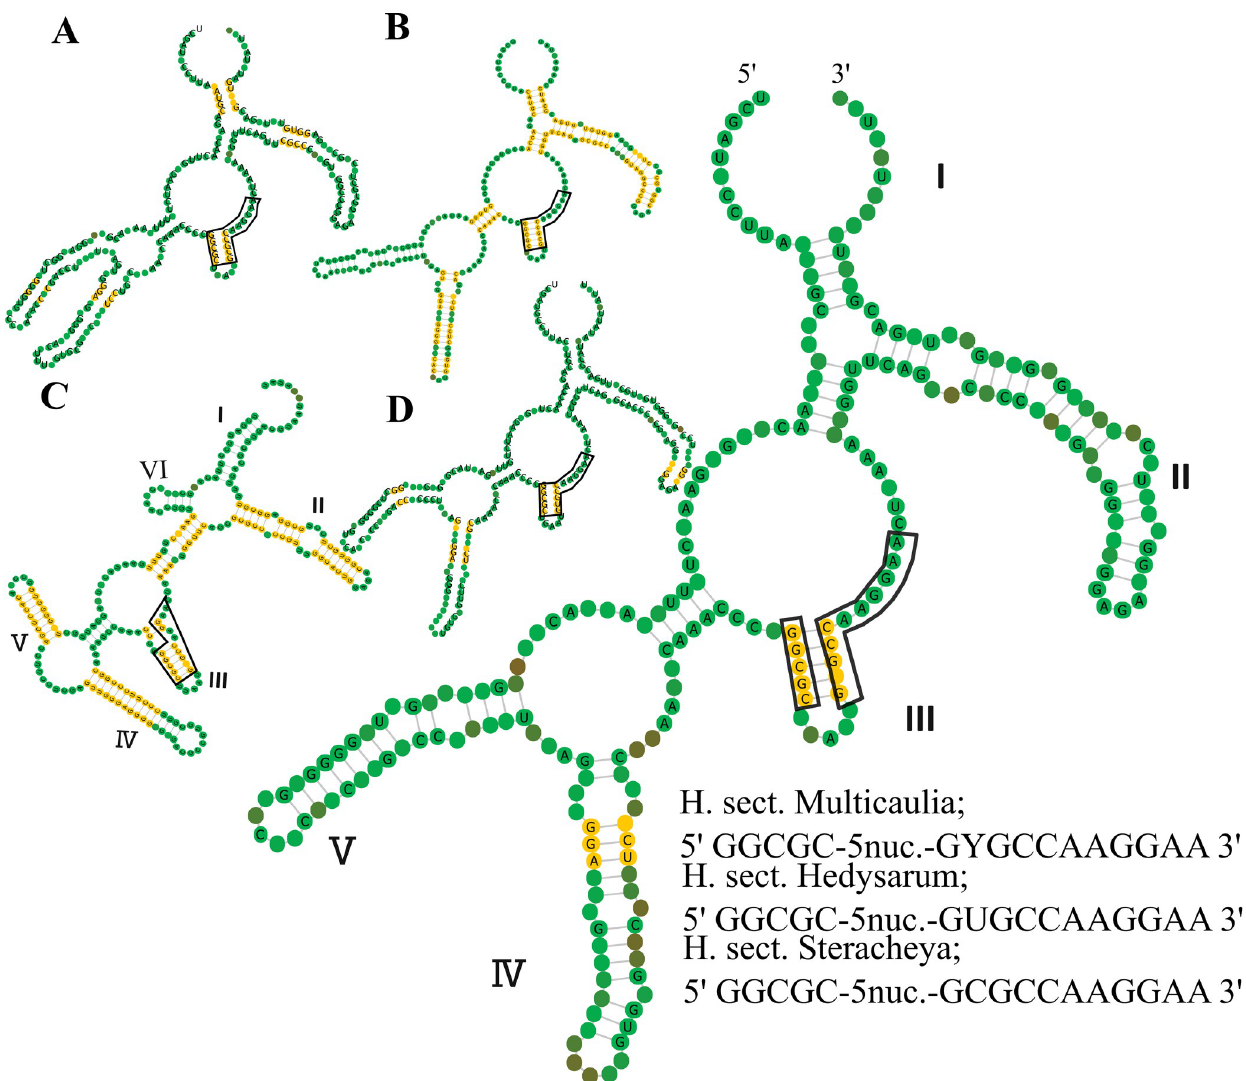
Fig 3. Olsen layout of ITS1 100% conserved consensus secondary structure of A. H . sect. Multicaulia subsect. Crinifera (clade C). B. H . sect. stracheya (clade S). C. H . sect. Multicaulia subsect. Multicaulia (clade M) and d. H . sect. Hedysarum (clade H). The blocks represent a conserved motif. https://doi.org/10.1371/journal.pone.0283847.g003 (MFE), are illustrated in Fig 3. The secondary structures of the CEGO clade have been choos- ing from five optimal and suboptimal structures. ITS1 secondary structure of clade H consisted of one large (second or third loop) plus two small central loops classified into two types. First loop with two, the second with zero, and the Table 4. Length of Helices of ITS1, ITS2 in clades. Helix 1; I Helix 2;